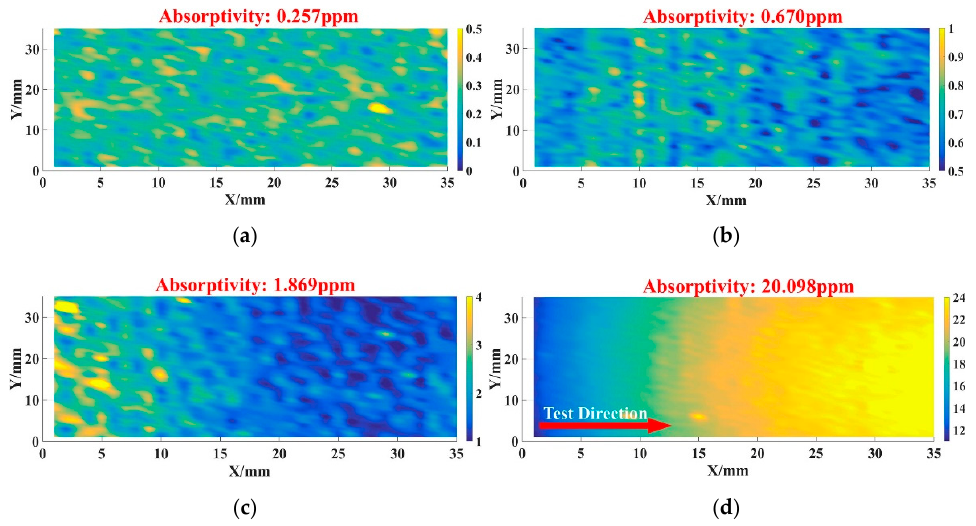
Figure 2. Absorptivity result of samples before dynamic chemical etching (DCE) process: ( a ) 1 ab- Figure sorptivity result; ( b ) 2 absorptivity result; ( c ) 3 absorptivity result; ( d ) 4 absorptivity result.